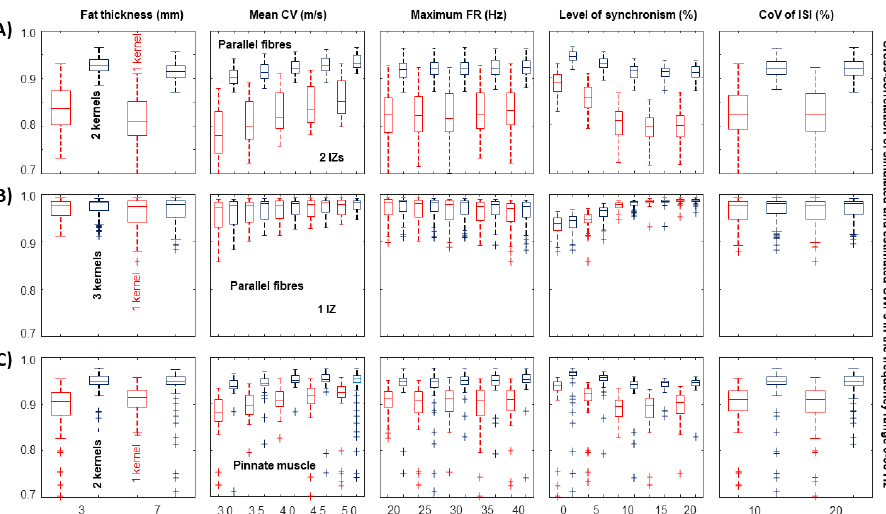
Figure 5. Cross -correlation of the low frequency contributions (up to 50 Hz) of the simulated CWF and estimated by either the single-kernel (red) or multi-kernel method (black). Each estimation was obtained considering single channel SD EMG at 80% MVC with a duration of 10 s. Data are shown after pooling with respect to specific values of fat layer thickness, mean MU CV, maximal FR, level of synchronization of MU firings, and CoV of ISI. Different simulation models are considered: ( A ) cylindrical volume conductor with parallel fibres and two IZs (50% of MUs innervated under each IZ; uniform distribution of MU size among different IZs); ( B ) same volume conductor as in ( A ), but considering a single IZ; ( C ) pinnate muscle with fibre inclined with respect to the skin